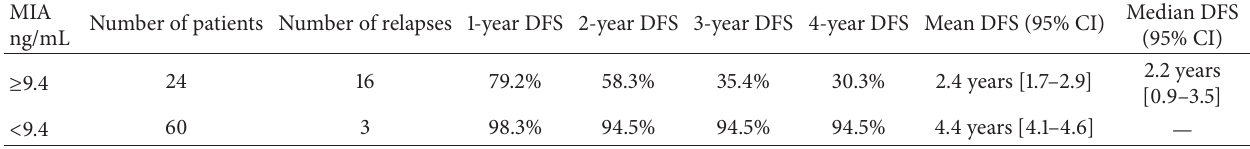
Table 2: Disease-free survival (DFS) rate of stages I and II melanoma patients according to MIA serum concentration.